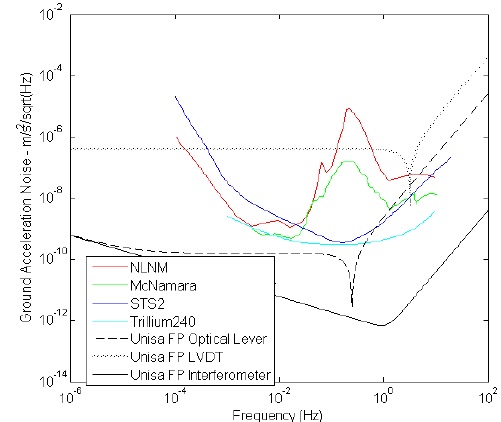
Figure 6. Sensitivity curves of the UNISA